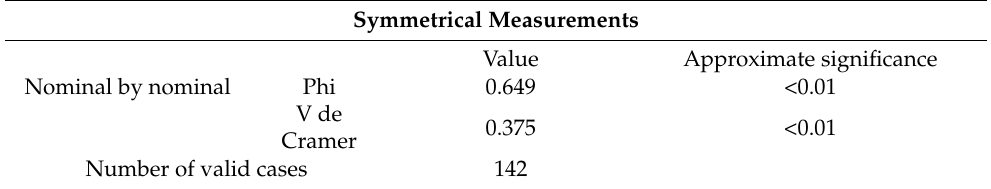
Table 1. This table shows the statistical association between the variable age and suture maturation. Symmetrical Measurements